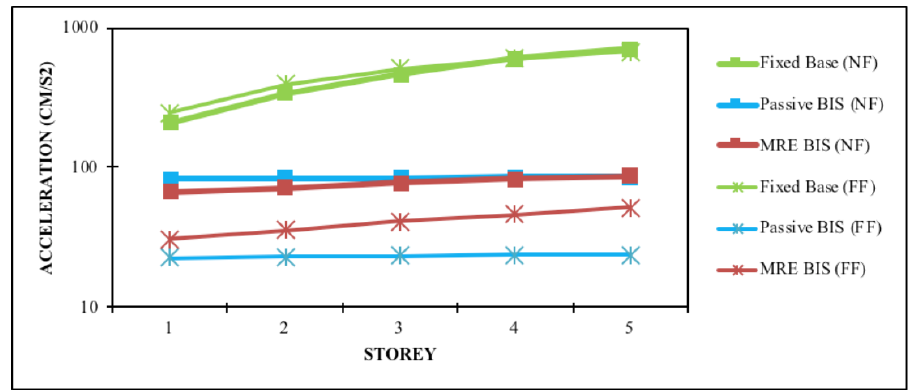
Figure 14. Peak acceleration, Kocaeli